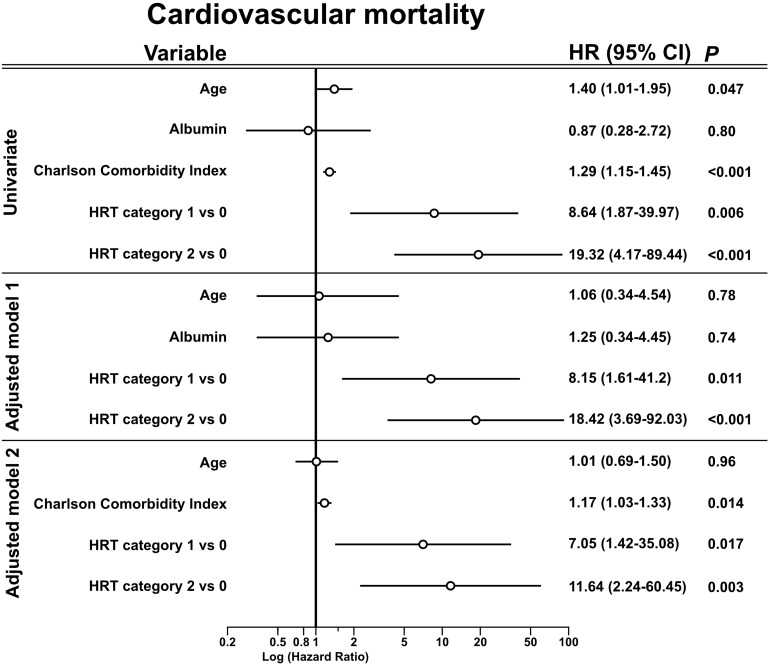
Association of risk variables with cardiovascular mortality in univariate and multivariable analysis. Univariate and multivariable Cox regression analysis for the association of the risk variable and cardiovascular mortality. Unadjusted and adjusted hazard ratios with the respective confidence interval are presented. Age has the unit 10 years. The adjusted Model 1 included age, albumin and HRT. The adjusted Model 2 included age, the Charlson Comorbidity Index and HRT. Units: Age, 10 years; Albumin, 1 g/dl; Charlson Comorbidity Index, 1 point. CI, confidence interval; HR, hazard ratio; HRT, heart rate turbulence.